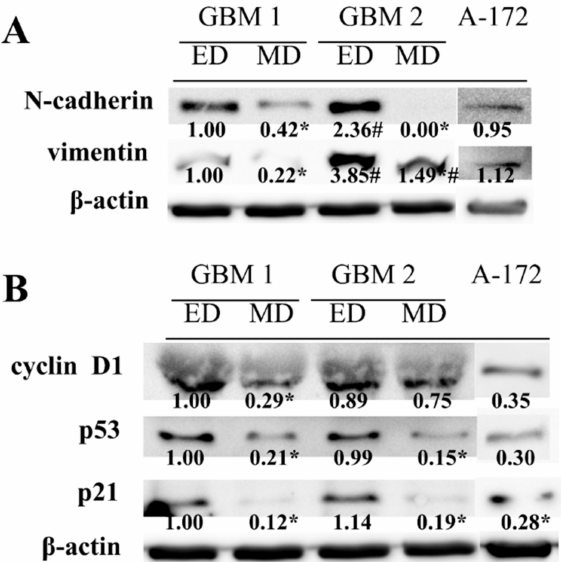
Figure 4. The comparison of protein expression in primary glioblastoma (GBM) cells obtained using enzymatic method (ED) and mechanic method (MD) from the GBM of two patients and in stabilized cell line A-172. Expression of mesenchymal markers, N-cadherin and vimentin ( A ), as well as cell cycle relevant cyclin D1, p53, and p21 ( B ) was determined by Western blot analysis. β -actin was used as a loading control. Measurements were performed in three independent experiments. * p < 0.05 ED vs. MD; # p < 0.05 ED vs. MD in GBM1 vs.